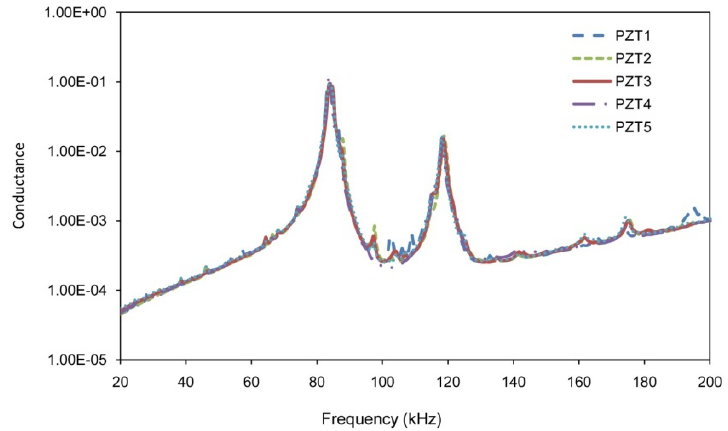
Figure 4. Free signatures of the PZT